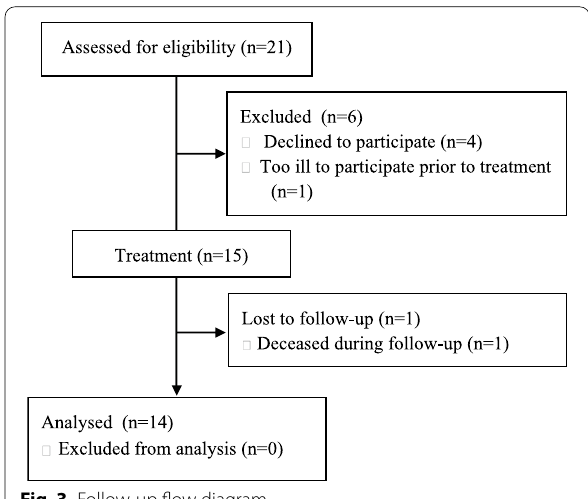
Fig. 3 Follow-up flow diagram